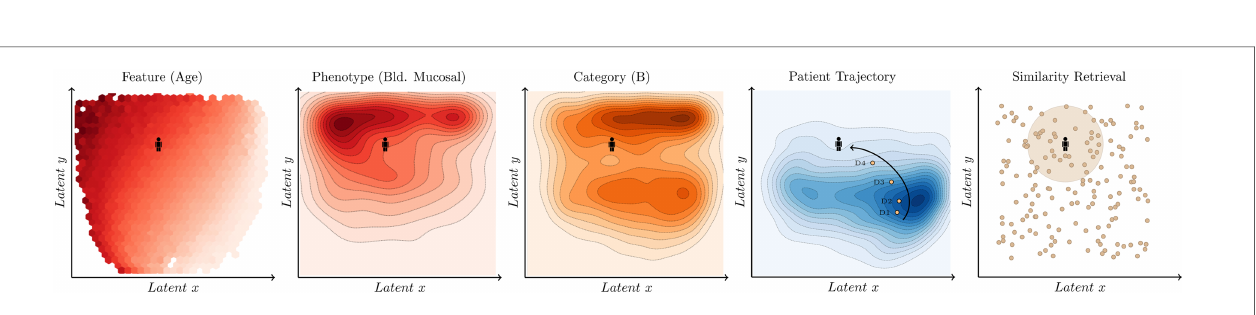
FIGURE 2 Latent space analysis. From left to right, the latent space produced can be described in terms of features using the average value (e.g. age) and phenotypes (e.g. mucosal bleeding) or categories (e.g. category which is associated with the warning signs de fi ned in the WHO 2009 dengue guidelines) using the density distribution. In addition, it is possible to visualise the evolution of the patient over time (patient trajectory) and retrieve previous past similar patients to support decision making (similarity